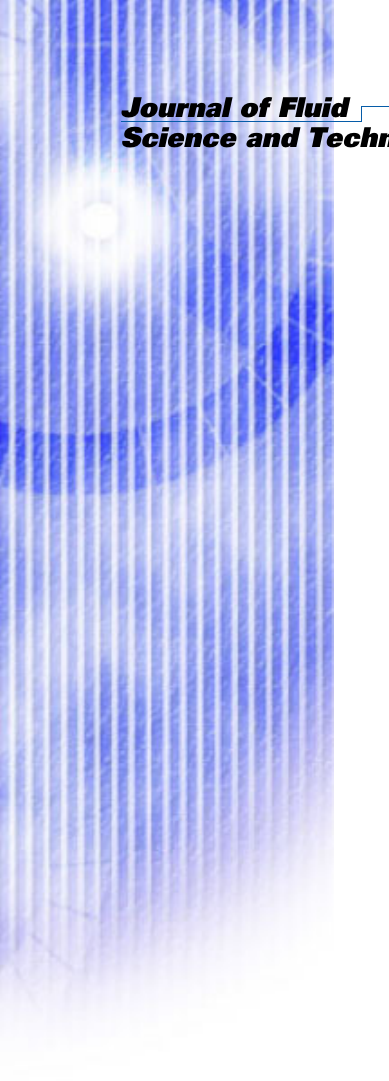
where the arbitrary constants are chosen as A 0 = 1 and ξ 0 = 0. The typical profiles of the real amplitude | A | for three cases of the initial void fraction α 0 are illustrated in Fig. 5. The height of the envelope soliton decreases with the decrease in α 0 , as in the case of the soliton solution of the KdV equation shown in Fig.